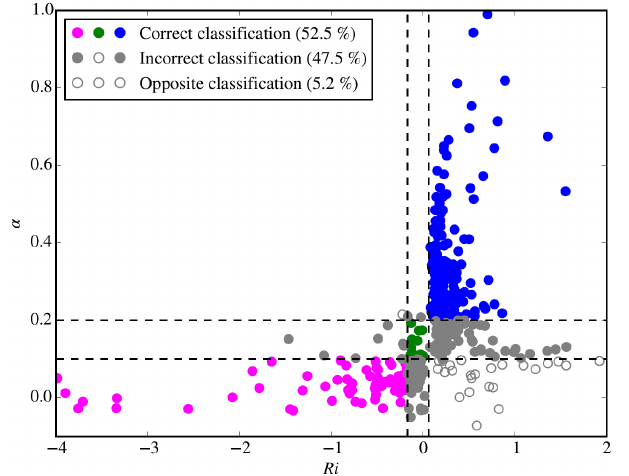
Figure 3. Richardson number from tower data at the ARM site vs. shear exponent calculated from WC data. Dashed lines denote sta- bility thresholds as defined in the text. Magenta, green, and blue circles correspond to times when the classification based on both Ri and α was unstable, neutral, or stable, respectively, and gray cir- cles correspond to times when the classification was different. Open gray circles denote times when the classification was stable based on Ri and unstable based on α or vice versa. Percentages of the to- tal combined Ri – α dataset corresponding to each case are shown in parentheses in the figure